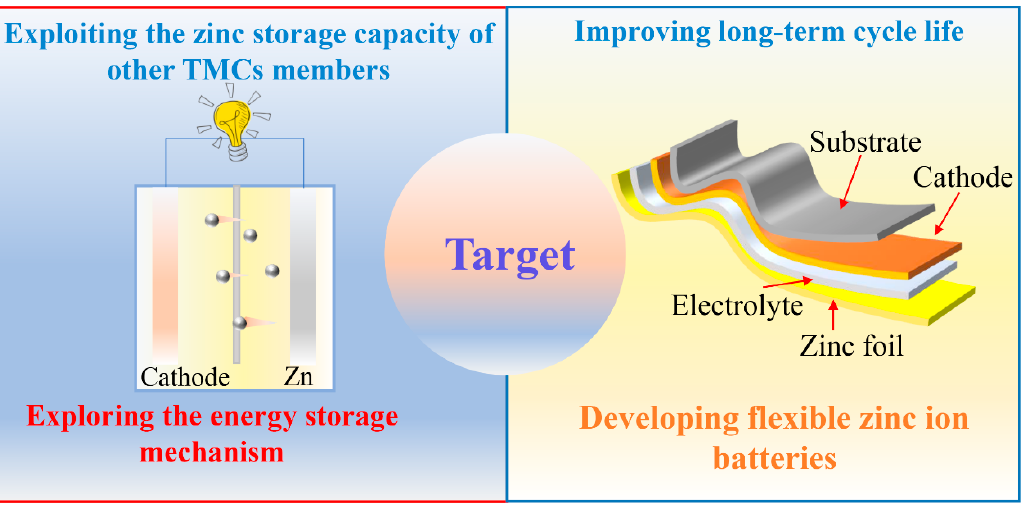
Figure 8. The future target of TMCs cathodes for AZIBs.